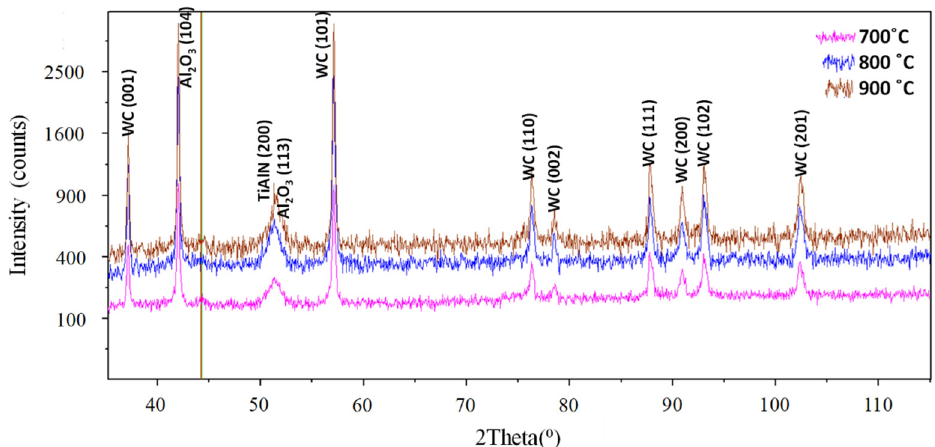
Figure 5. X-ray diffraction patterns of oxidation products generated at 700 °C, 800 °C and 900 °C (showing formation of Al 2 O 3 layer over Ti 0.45 Al 0.55 N basic layer) [13].